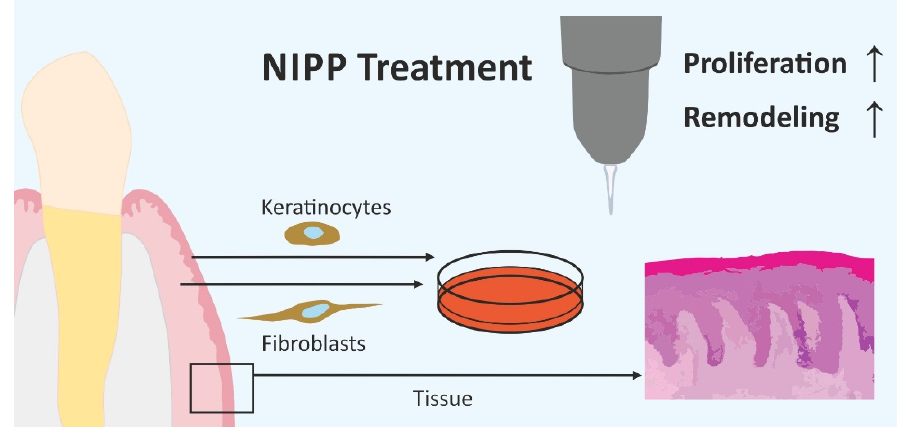
Figure 10. Markers of proliferation and remodeling were upregulated by NIPP in HGF, HGK, and tissue biopsies.